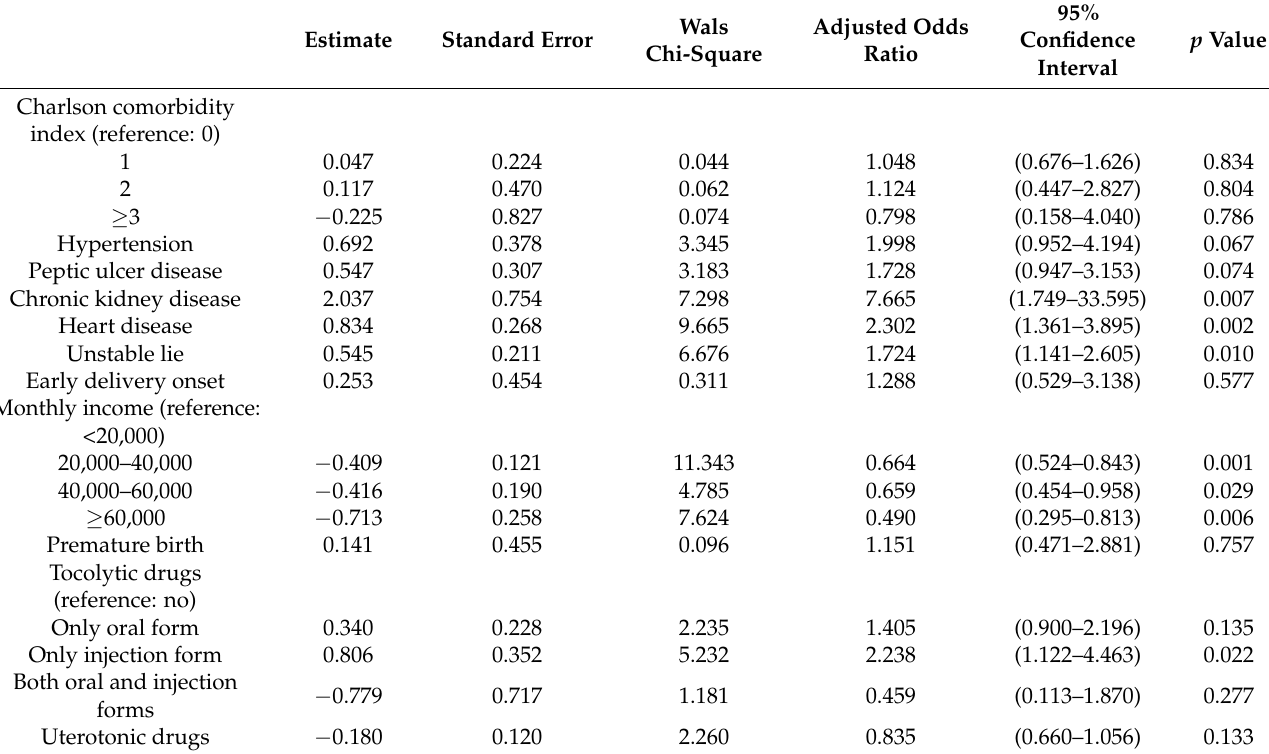
Table 2. Multivariate analyses of certain risk factors of